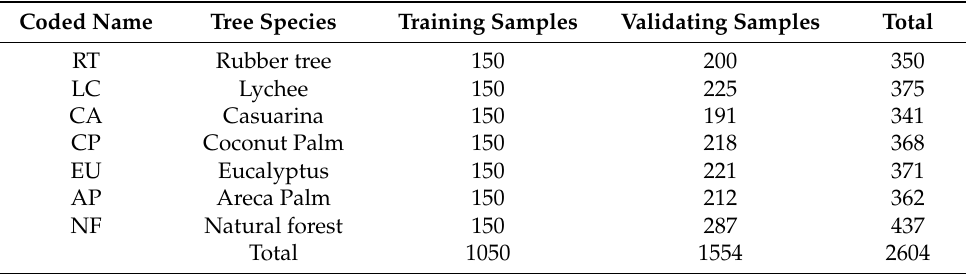
Table 1. Number of training and validating